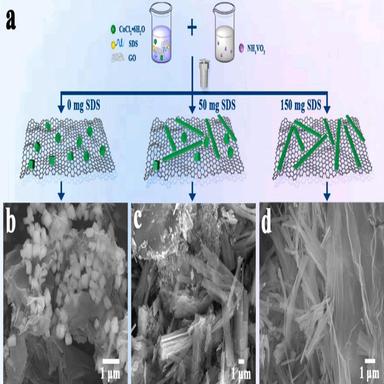
(a) Synthetic scheme of CoVO composites, product SEM images in different SDS mass: (b) 0 mg, (c) 50 mg, (d) 150 mg.